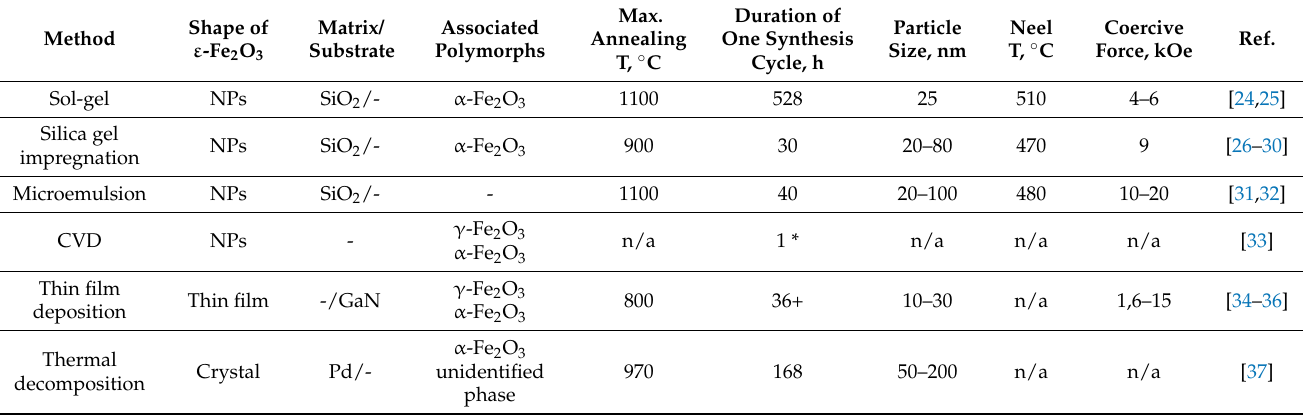
Table 1. Main characteristics of the methods for the synthesis of ε -Fe 2 O 3